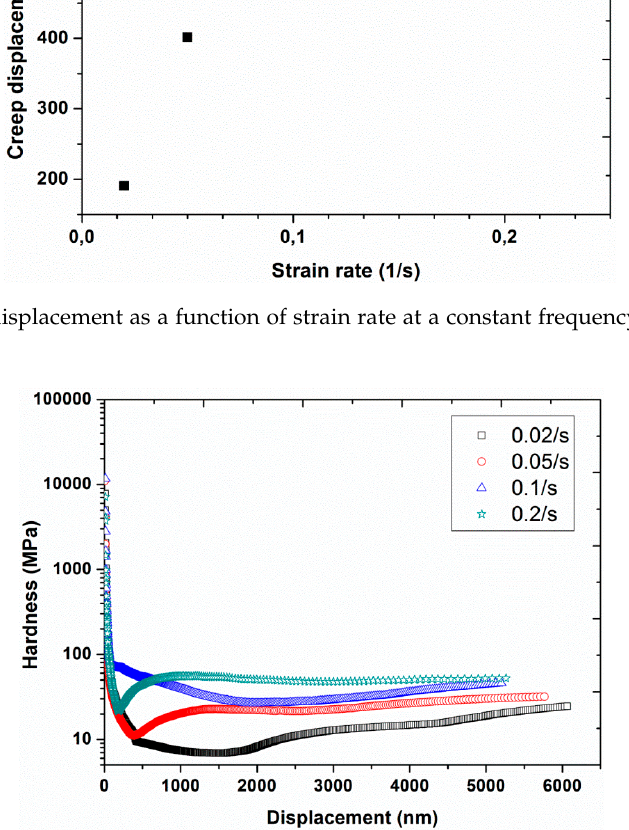
Figure 11. Hardness as a function of displacement for the four different strain rates (0.02, 0.05, 0.1, and 0.2 s − 1 ) at a frequency of 45 Hz and vibration amplitude of 2 nm.